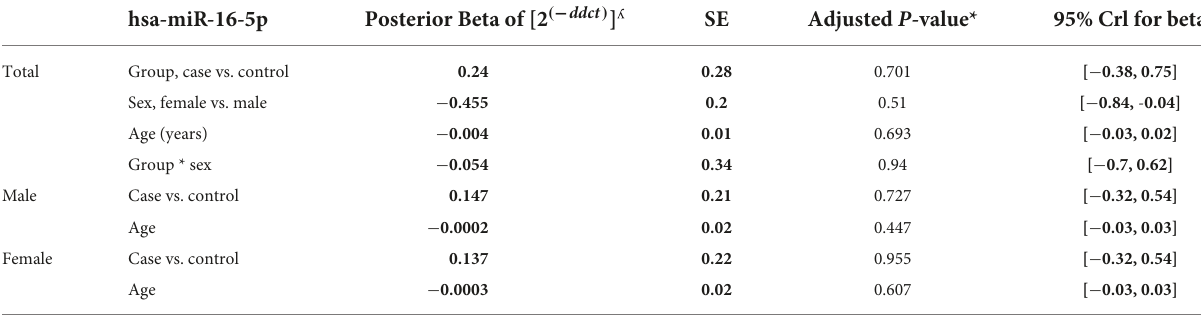
TABLE 6 Relative levels of miR-16 in AD cases and controls according to the Bayesian quantile regression model. hsa-miR-16-5p Posterior Beta of [2 ( − ddct ) ] SE Adjusted P -value* 95% Crl for beta Total Group, case vs. control 0.24